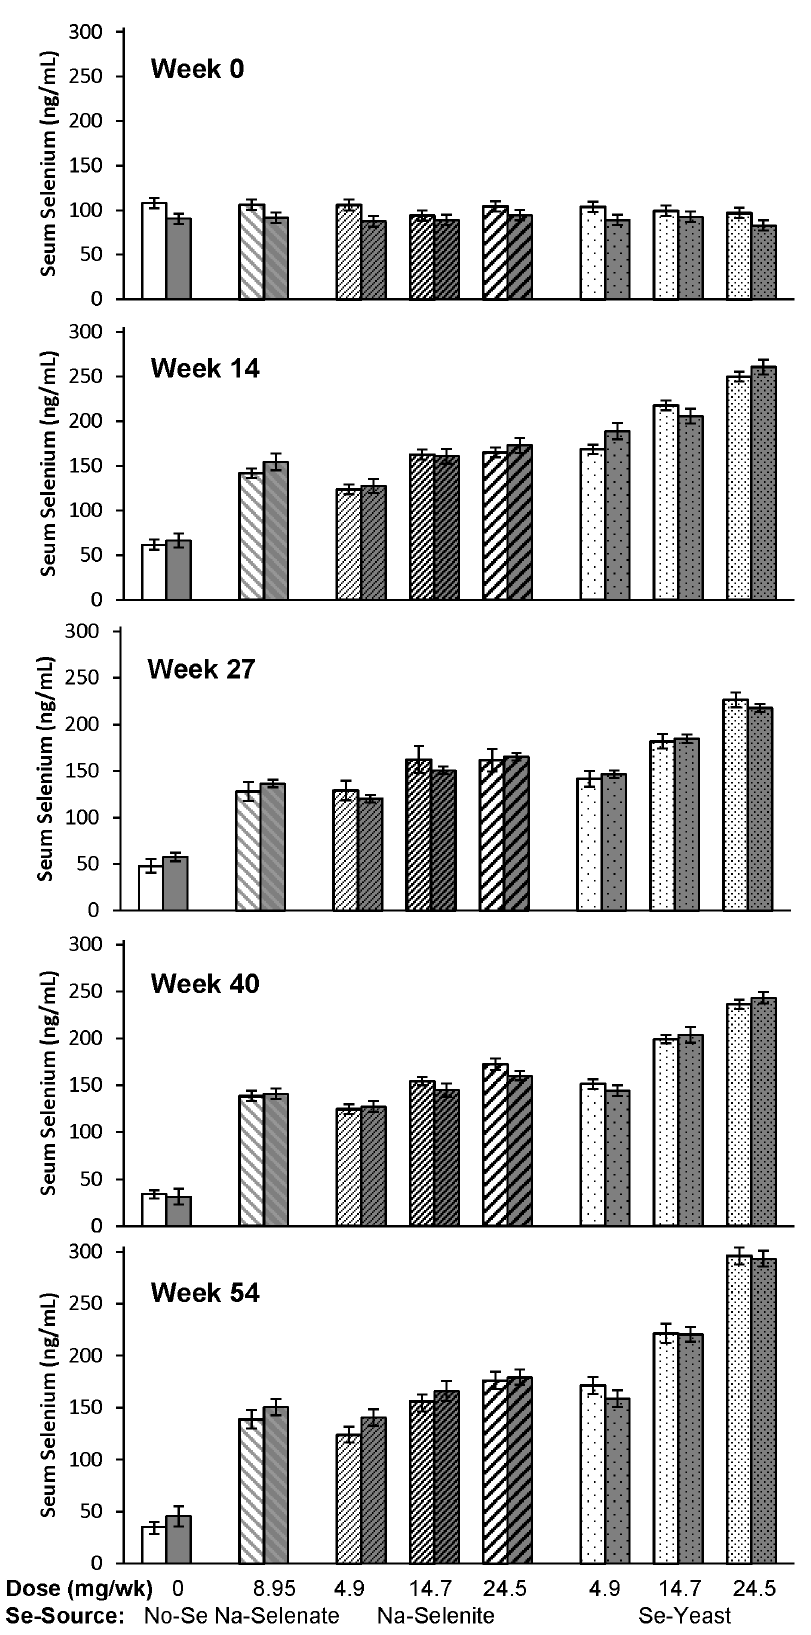
Figure 3. The effect of Se-source, Se-dosage, and foot rot status on serum-Se concentrations in sheep. Serum-Se concentrations were measured after 0, 14, 27, 40, and 54 wk of Se supplementation, and foot rot severity was assessed after 0, 20, 28, 40, and 60 wk of Se supplementation